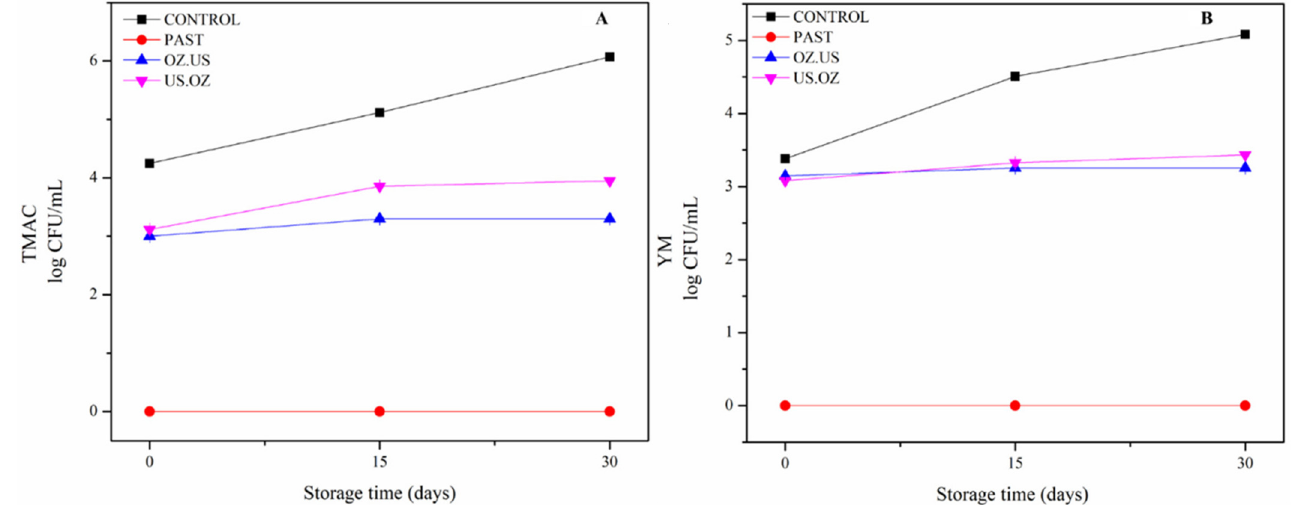
Figure 6. Total mesophilic aerobic bacteria microorganisms (log CFU/mL) ( A ) and yeasts and molds ( B ) counts (log CFU/mL) during cold storage of unprocessed ( ), PAST ( ), OZ.US ( ), and US.OZ ( ) cashew apple juice.